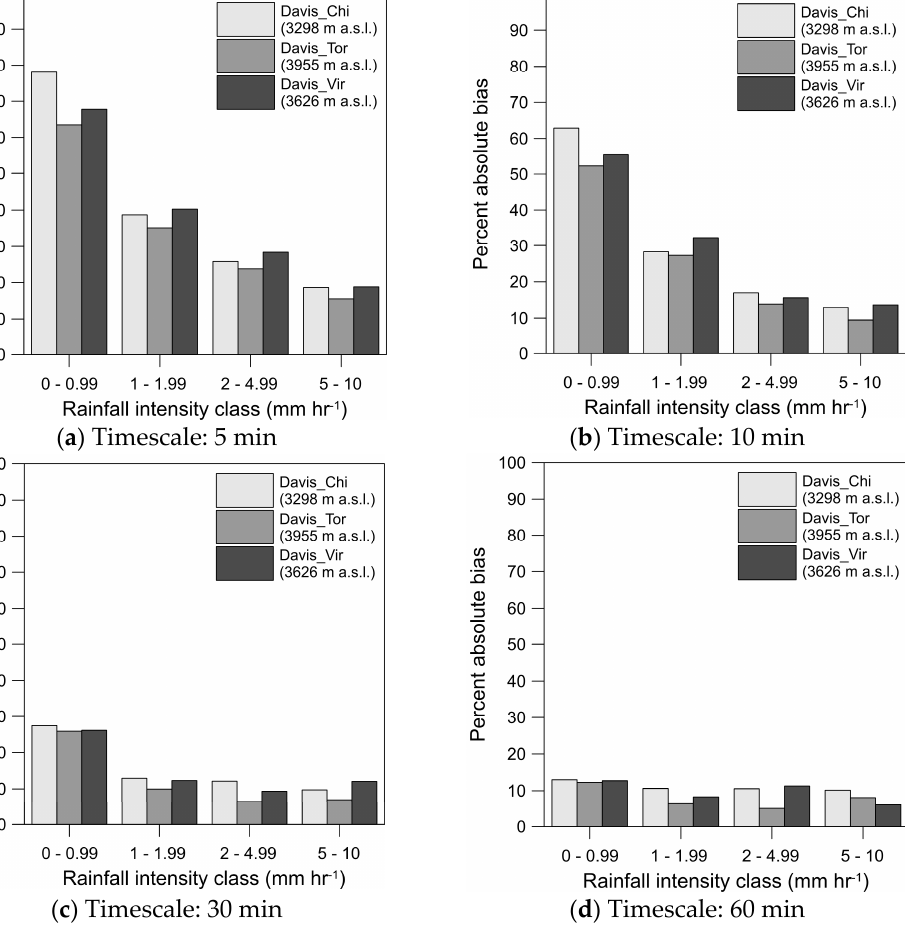
Figure 4. Percent absolute bias calculated with the CS method of the Davis with respect to the Texas TB rain gauge for different rainfall intensity classes and timescales, along an altitudinal gradient.